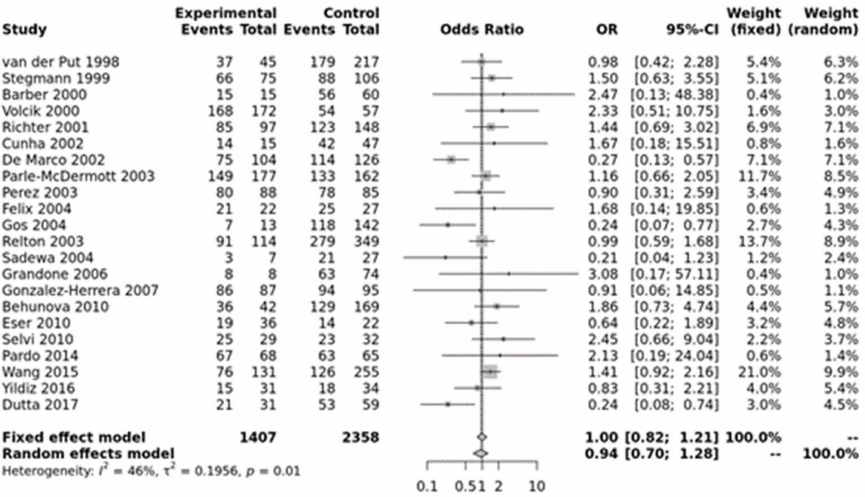
Figure 2. Homozygous model for MTHFR A1298C. Van der Put [34], Stegmann [49], Barber [50], Volcik [51], Richter [19], Cunha [52], De Marco [25], Parle-McDermott [26], Perez [36], Felix [53], Gos [54], Relton [28], Sadewa [37], Grandone [55], Gonzalez-herrera [56], Behunova [57], Eser [39], Selvi [58], Pardo [45], Wang [46], Yildiz [59], Dutta [47]. MTR A2756G SNP has been associated with NTDs. Our pooled analysis showed no association between MTR and NTDs. For example, the recessive model was not significant (GG vs. GA + AA, OR = 0.99, 95% CI 0.84–1.17, p > 0.10) (Figure 3). The Egger’s test showed no bias ( p = 0.75) and the funnel plot showed no heterogeneity (Figure